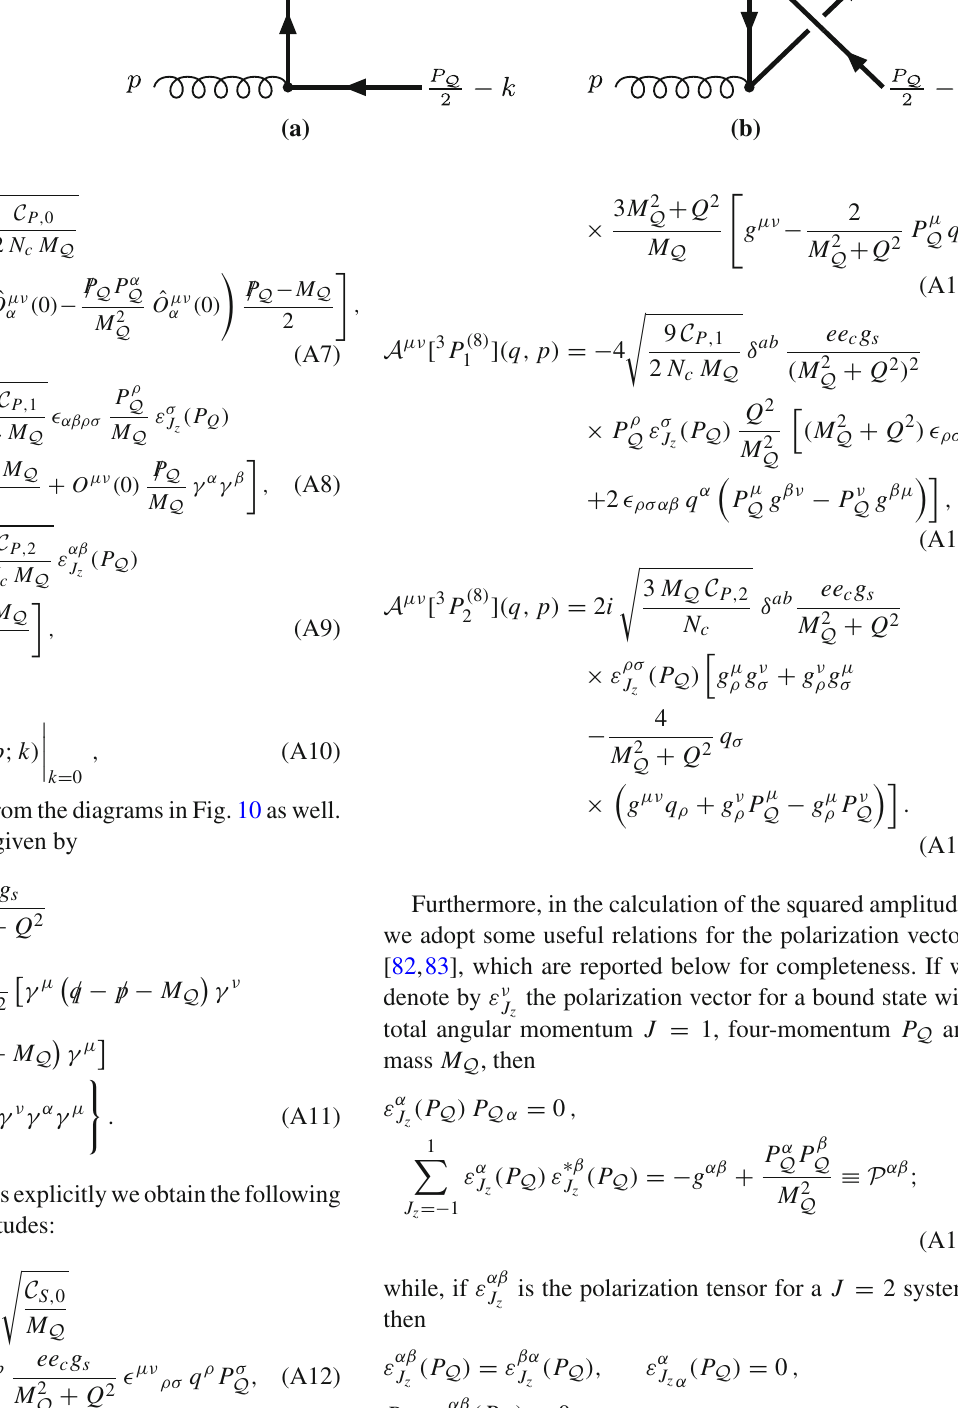
Fig. 10 Feynman diagrams for the partonic subprocess γ ∗ ( q ) + g ( p ) → Q ( P Q ) at LO in perturbative